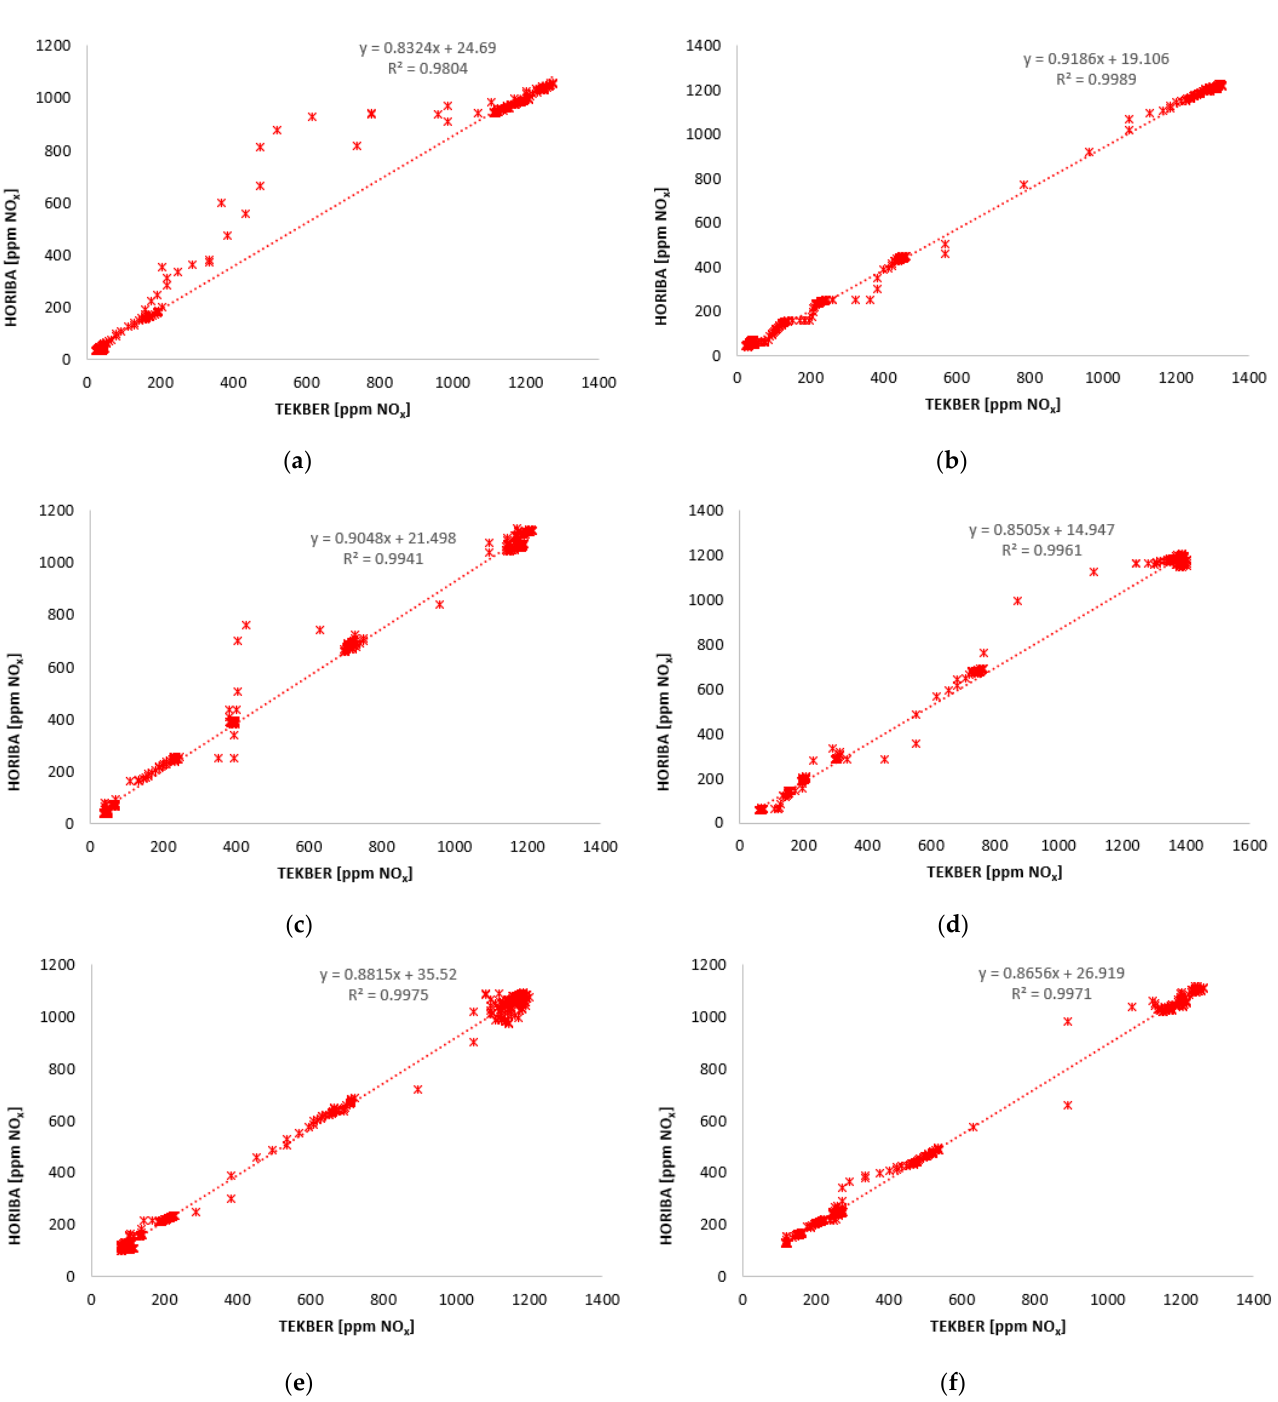
Figure 8. Correlation between concentration values from Tekber and Horiba equipment: ( a ) @800 rpm, ( b ) @1000 rpm, ( c ) @1500 rpm, ( d ) @2000 rpm, ( e ) @2500 rpm, ( f ) @3000 rpm.